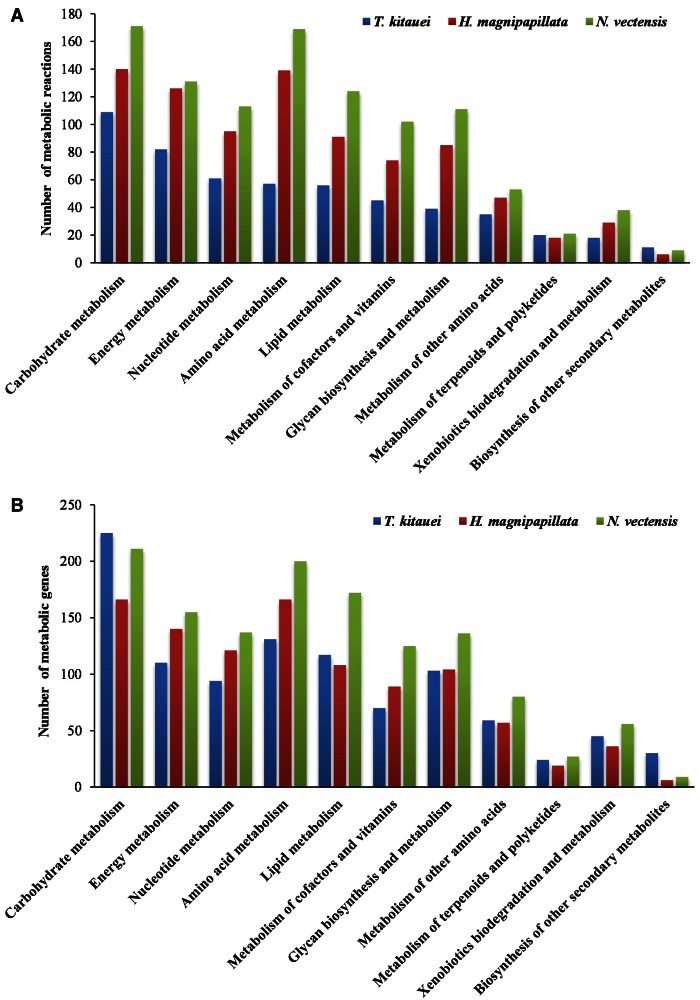
Number of metabolic reactions (A) and number of metabolic genes (B) in comparison between T. kitauei and two free-living cnidarias.